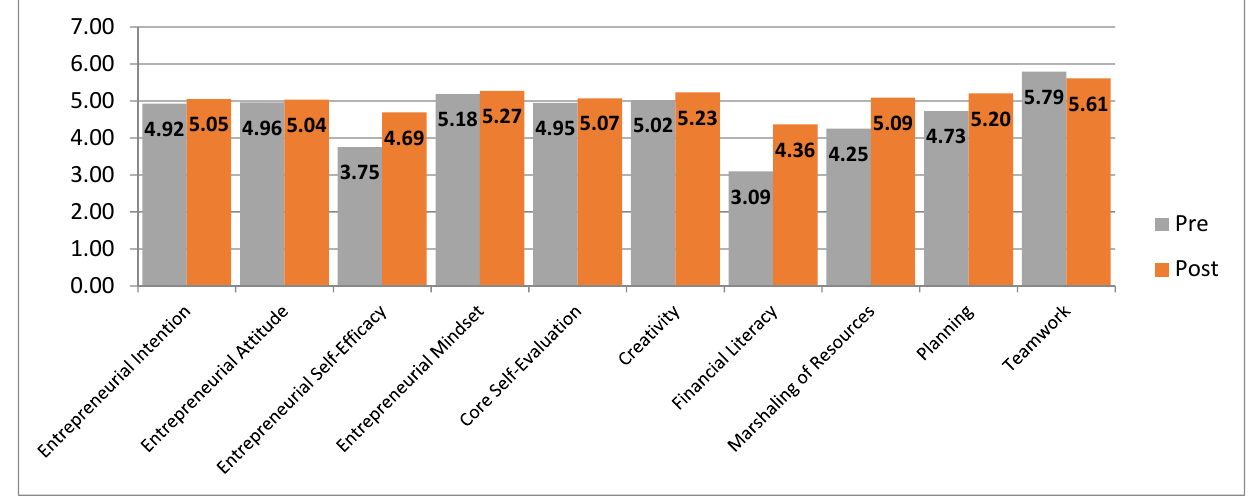
Figure 5. The average values of the entrepreneurial characteristics, pre- and post-course, of the PhD students.